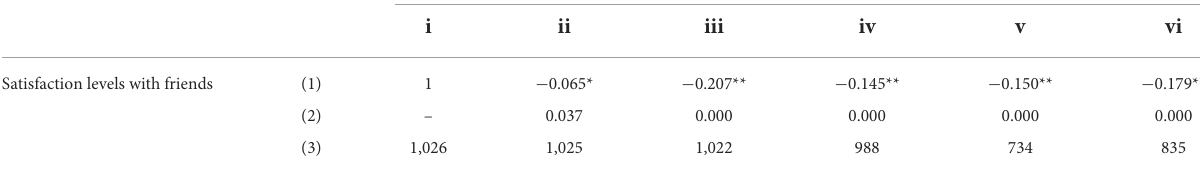
Satisfaction levels with